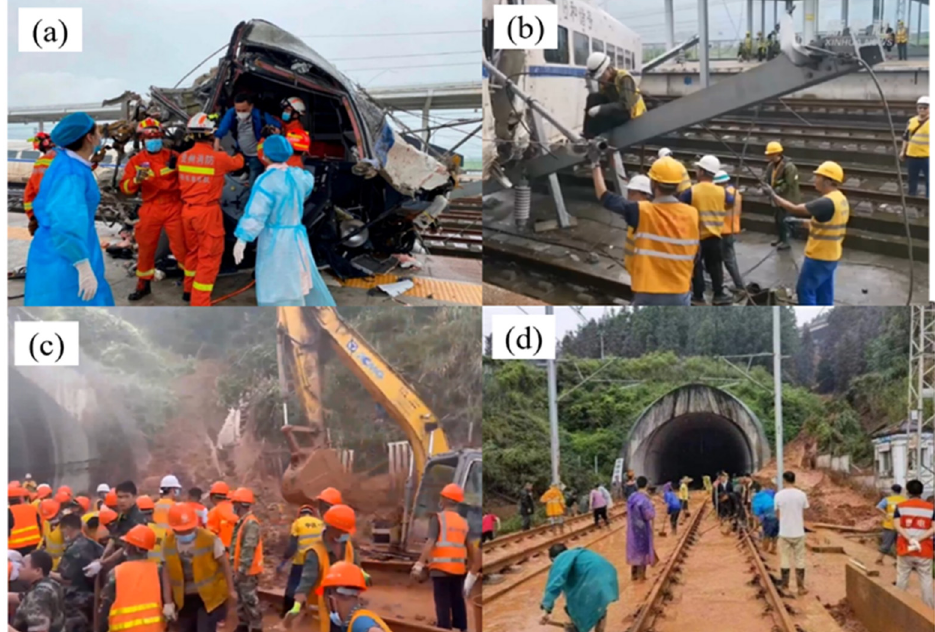
Figure 3. Rescue operation: ( a ) Firefighters rescuing trapped people; ( b ) Staff cleaning up the accident train; ( c ) Track debris flow removal; ( d ) Clearing debris flow intruding into the line (Source: Xinhua News Agency https://haokan.baidu.com/v?pd=wisenatural&vid=2796812779194810025, accessed on 24 June 2022).